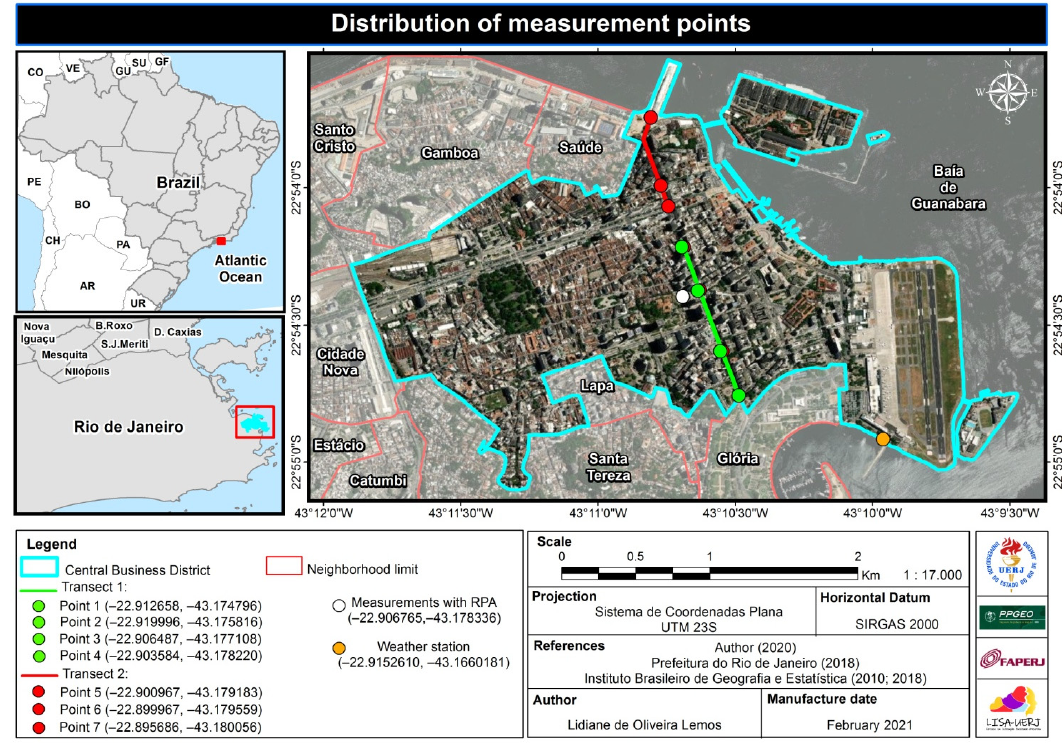
Figure 1. Study area and distribution of measurement points.